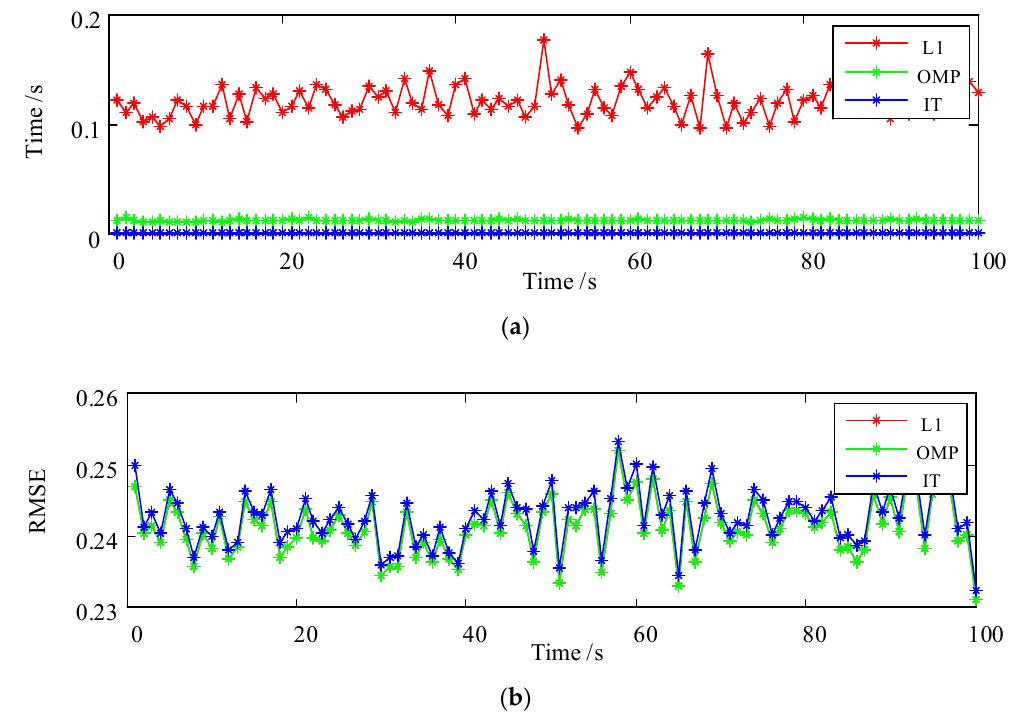
Figure 7. Reconstructed time and quality of different algorithms. ( a ) Reconstructed time; ( b ) recon- structed quality.